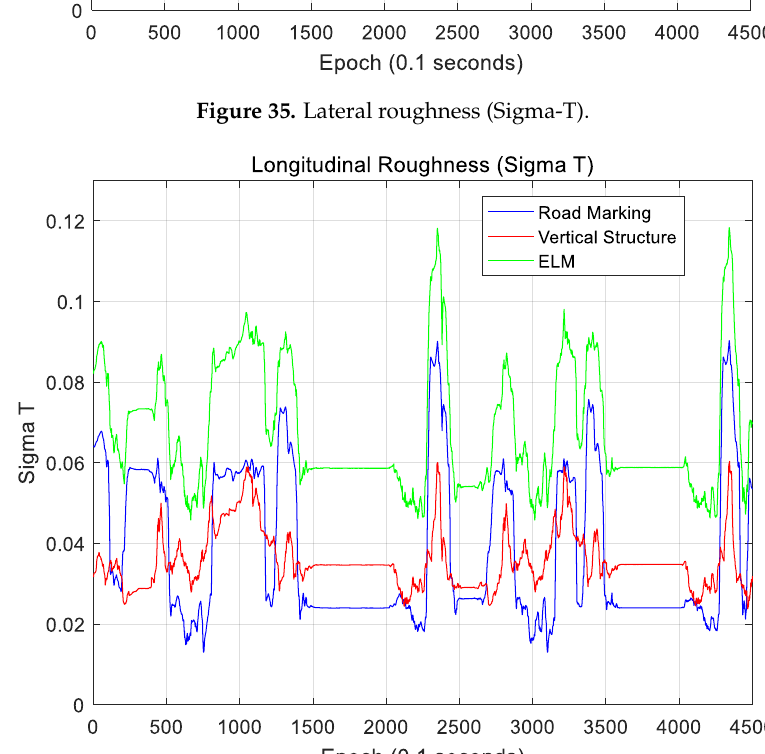
Figure 36. Longitudinal roughness (Sigma-T).